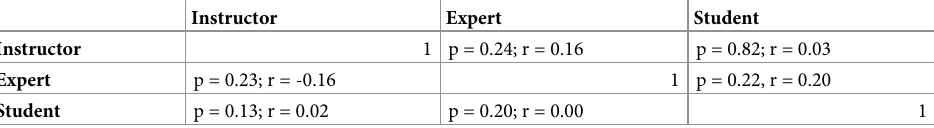
Table 4. Mantel tests between primary and secondary subscale scores. Correlation coefficients and p-values in upper corner compare primary subscale scores, while correlation coefficients in the lower corner compare secondary subscale